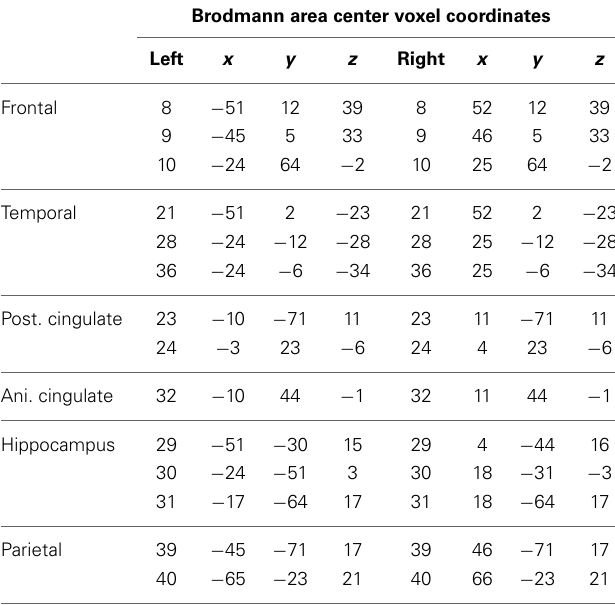
Table 1 | List of the Brodmann areas of the Default Mode Network (DMN) based on Buckner et al.